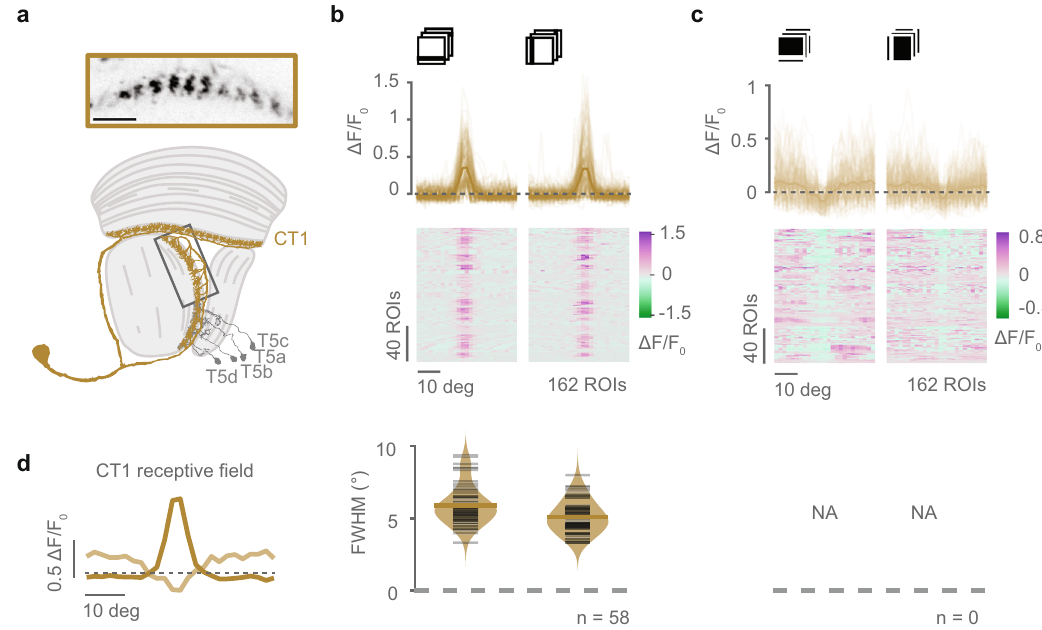
Fig. 5 CT1 neuron responses contain ON and OFF information. a Example average intensity projection from recordings of axon terminals from a single CT1 neuron (top), and a schematic of the optic lobe showing the anatomy of the CT1 neuron (bottom). Scale bar = 10 μ m. b Top: OFF receptive fi elds obtained from in vivo two-photon calcium imaging of responses to horizontal and vertical dark bars from CT1 neurons expressing GCaMP6f. Shown are all recorded ROIs ( n = 162, thin brown lines, from 15 fl ies) and mean across ROIs (thick brown lines). Bottom: Full width at half maximum (FWHM) from receptive fi elds obtained from horizontal and vertical OFF bars from ROIs in top panel fi tted by a Gaussian. Only neurons (ROIs) with response quality index above 0.5 and r 2 > 0.2 are shown, similarly to Fig. 4j – m. n = 58 ROIs from 15 fl ies. c As in b but for ON receptive fi elds. Top: CT1 responses to horizontal and vertical ON bars in light brown. Bottom: The CT1 ON receptive fi elds could not be well- fi tted by a Gaussian. d Average receptive fi elds from vertical OFF and ON bars from b , c overlaid to visualize the spatial organization of CT1 responses to ON and OFF bars. n = 162 ROIs from 15 fl ies. Source data are provided as a Source Data fi